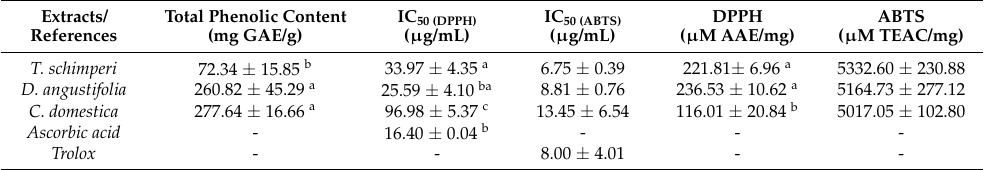
Table 1. Total phenolic content, DPPH, and ABTS radical scavenging capacities of plant extracts. Extracts/